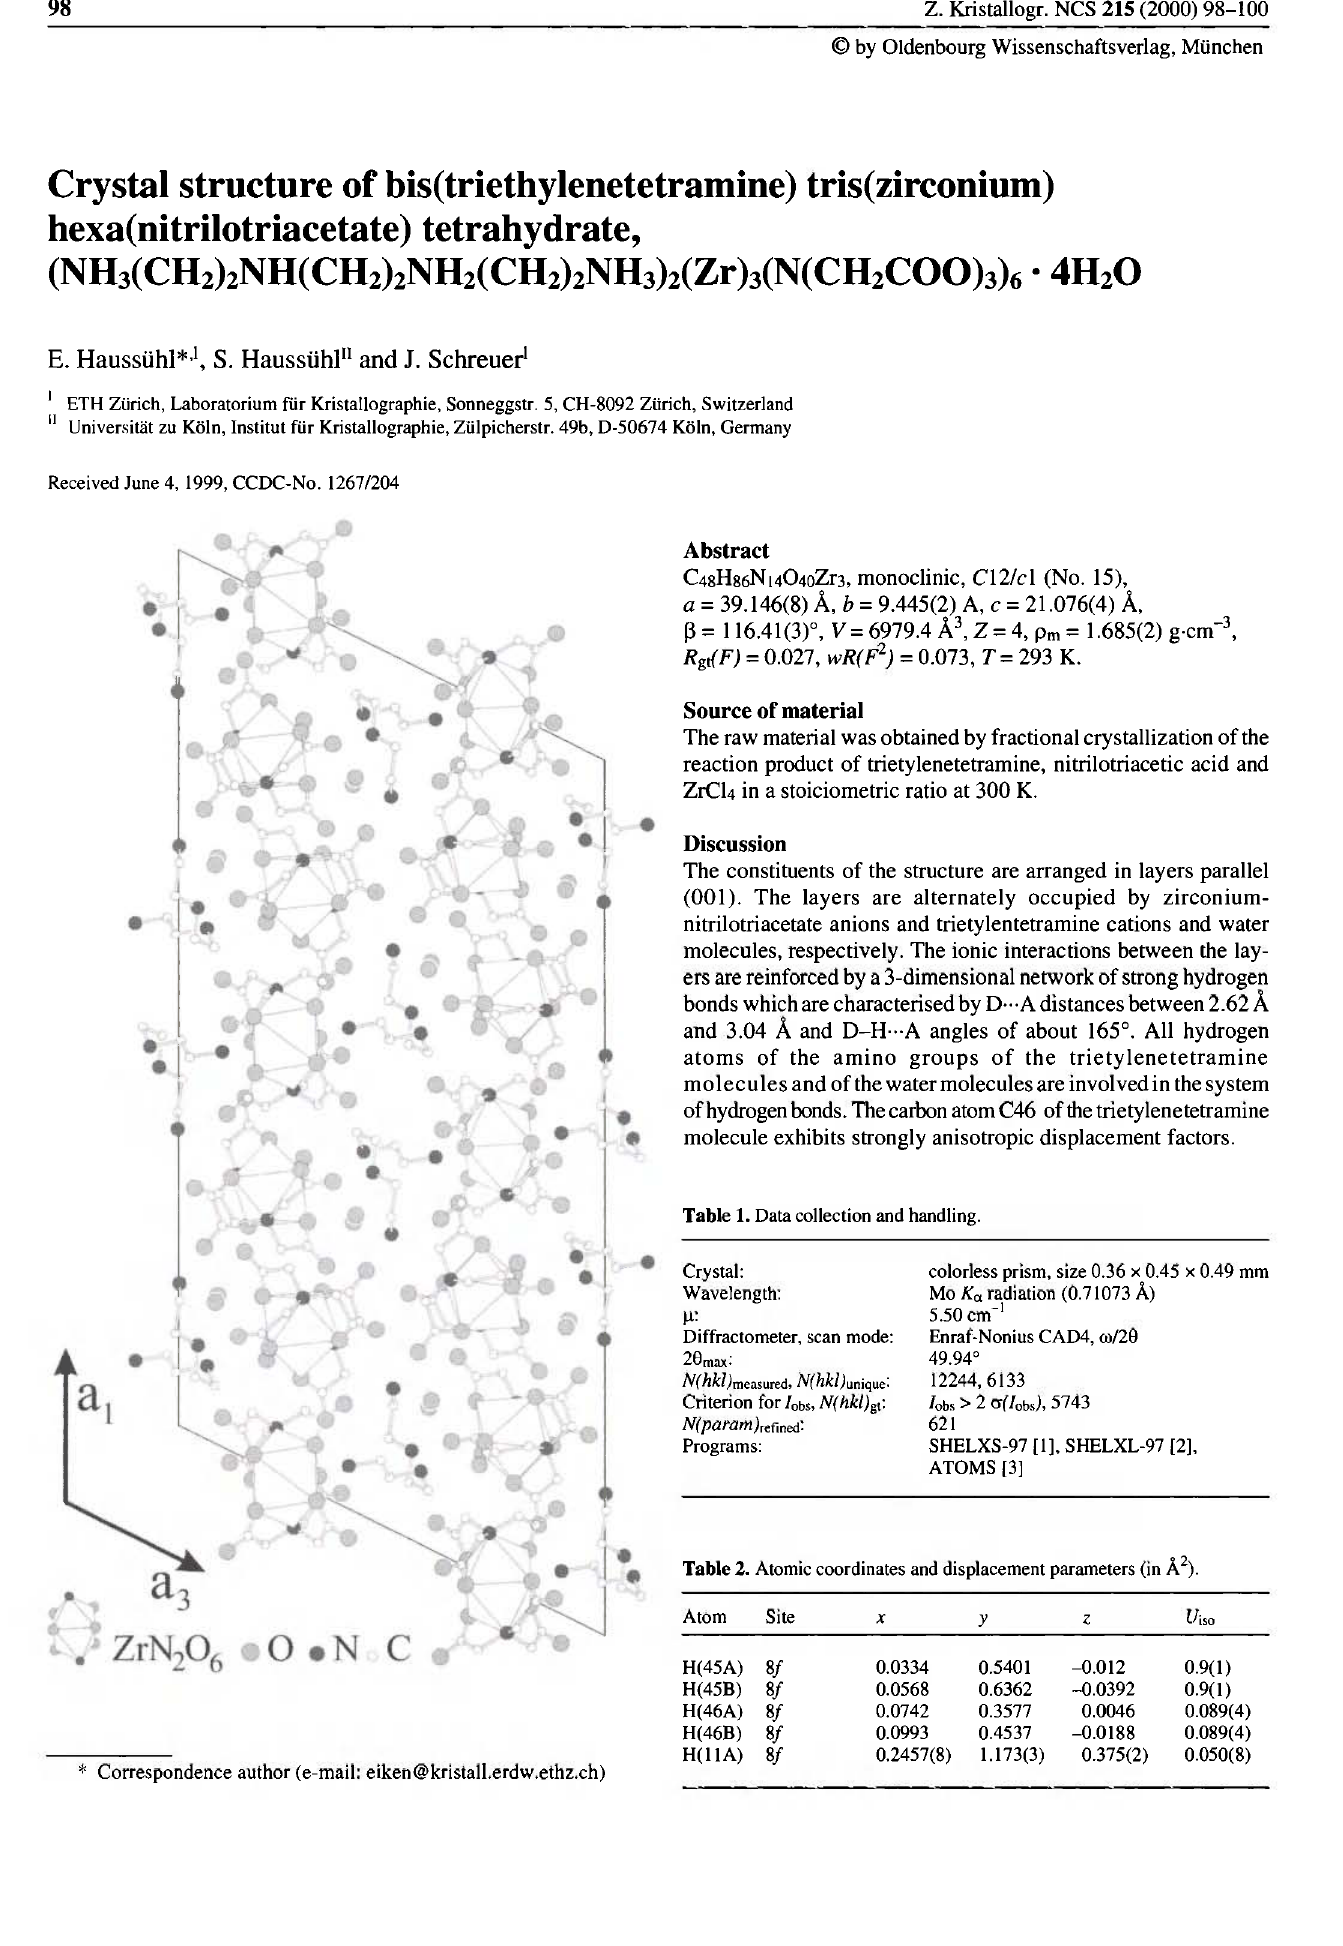
Table 2. Atomic coordinates and displacement parameters (in Ä 2